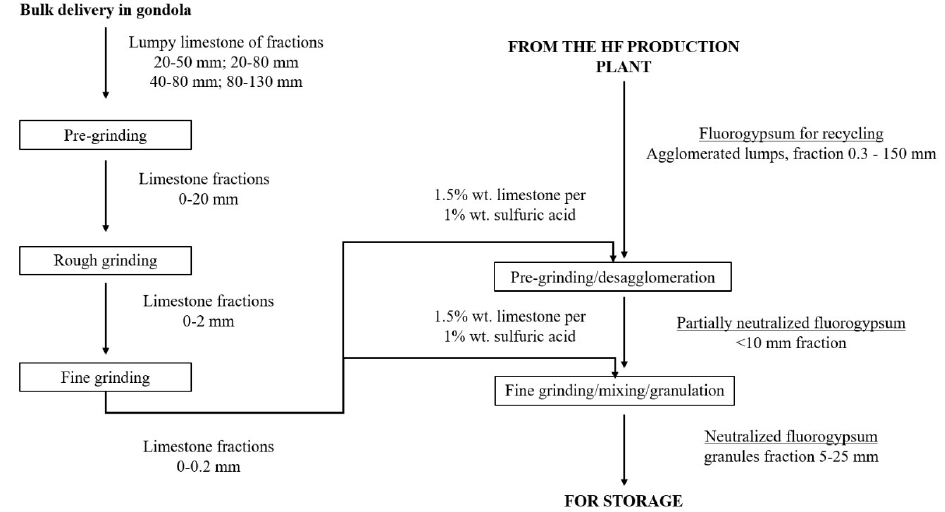
Figure 1. Technological scheme of fluorogypsum neutralization.